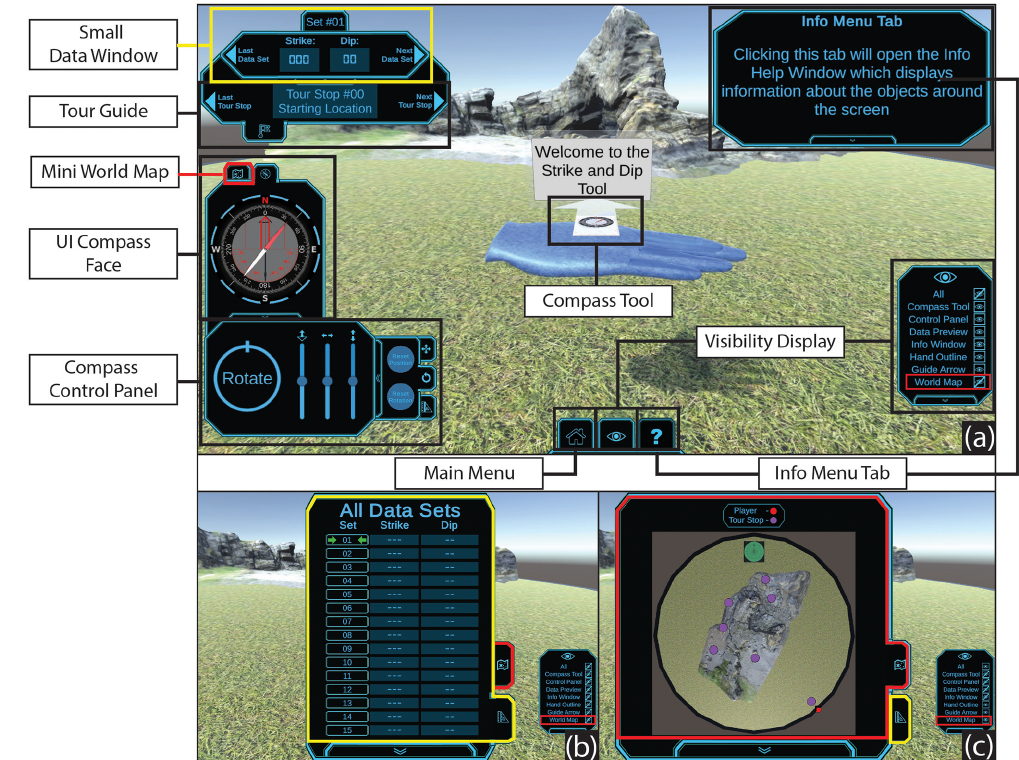
Figure 2. The SaD HUD (heads-up display). The HUD is composed of all the tools visible on screen throughout the program. Each tool can be toggled on/off depending on user preference. (a) The main HUD shows the Small Data Window , where the user’s most recent strike and dip measurements are displayed. The Tour Guide allows the user to view the stop at which they are presently located. The Mini World Map (red outline) shows the user their location in a miniature view. The user may view the compass with more ease using the UI Compass Face while they are measuring the orientation of the rock with the Compass Tool. The Compass Control Panel is used to position the compass on the outcrop/board to measure orientation. The Main Menu display allows the user to adjust the speed at which they/the compass move, the level they are on, and more personalization features. The Info Menu Tab gives brief information about each tool when the user hovers over them. Finally, the Visibility Display allows the user to toggle on/off each tool. (b) If the user wishes to view their entire strike and dip log, they can click on the triangle protractor icon (yellow outline). (b) The user can also click on the World Map (red outline) to obtain a full-screen view of their location in the